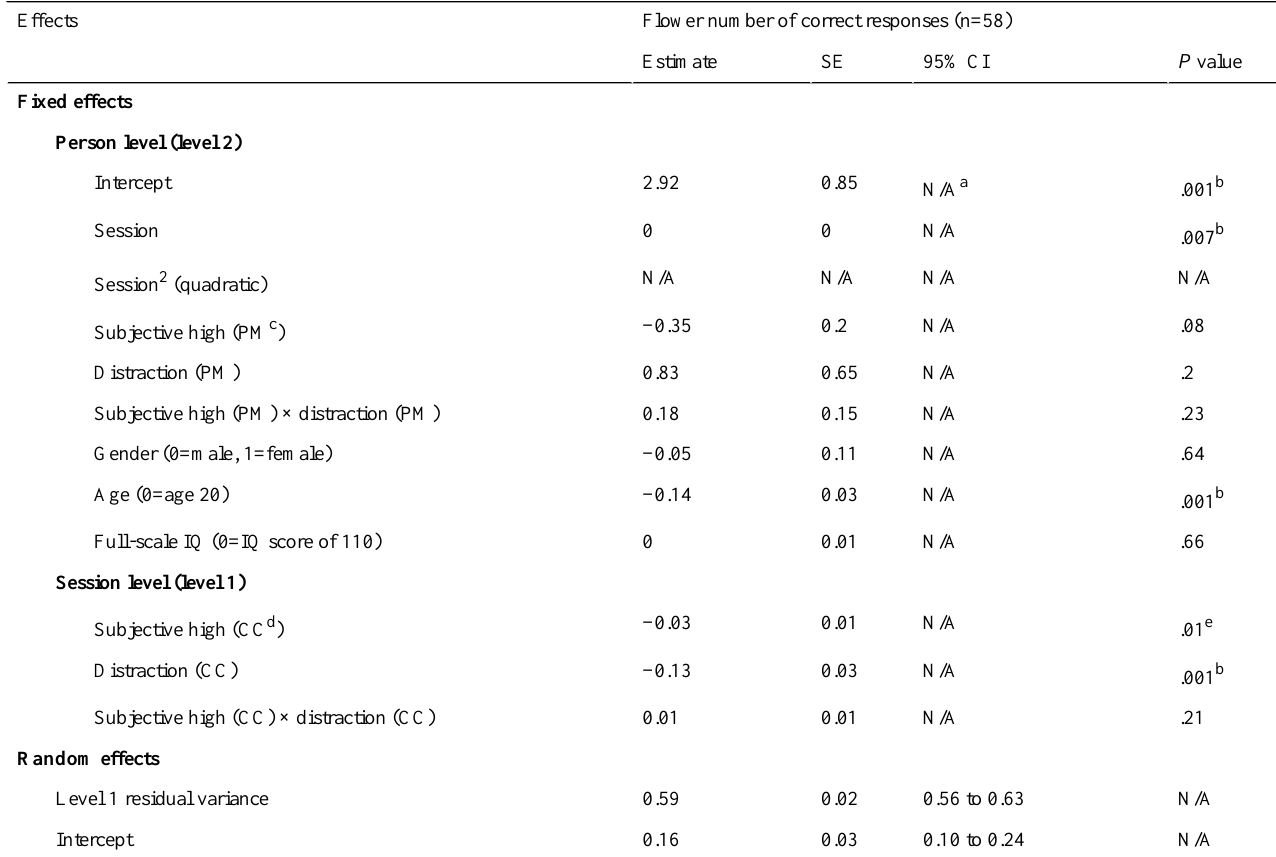
Table 6. Flowers task: multilevel model of marijuana high in relation to number of correct